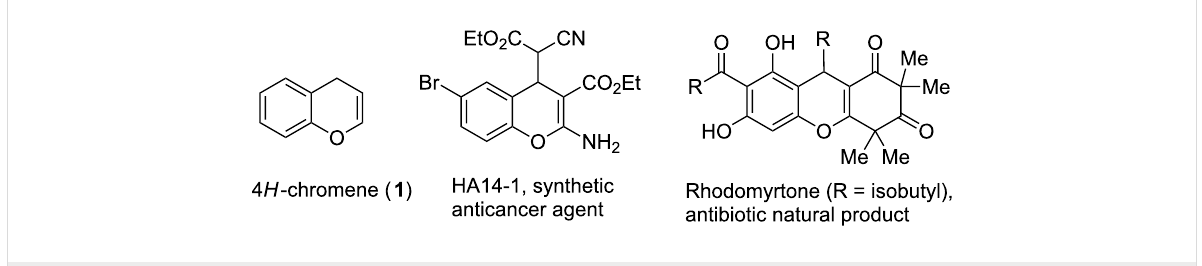
Figure 1: 4 H -chromene ( 1 ) and some of its biologically active derivatives.